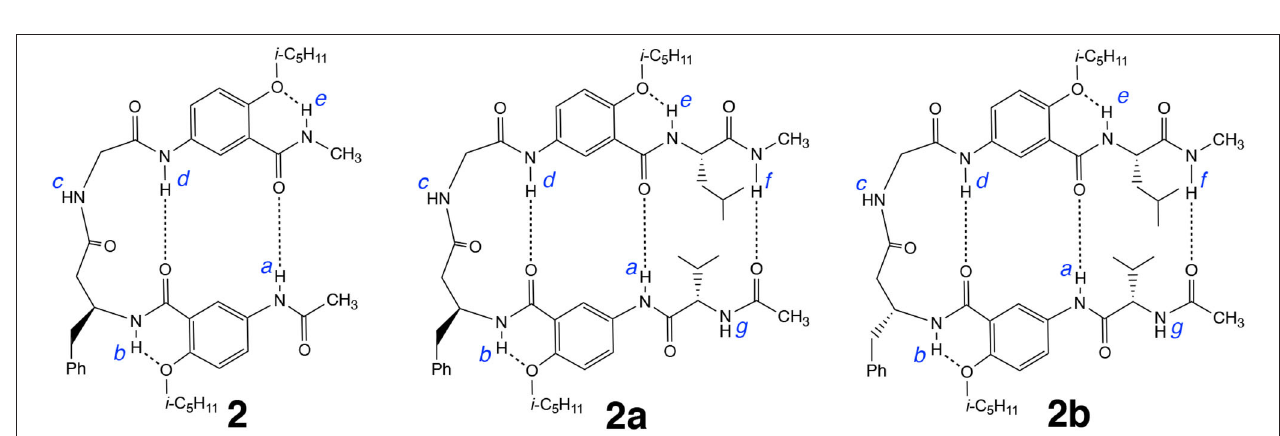
FIGURE 5 | Partial NOESY spectra of hexapeptide 1a (5mM) in 1, 1, 2, 2-tetrachloroethane- d 2 containing 5% DMSO- d 6 (600 MHz, 298K, mixing time: 300ms). Major NOEs are indicated by double-headed arrows in the structure. Partial NOESY spectra showing NOEs between protons a and h , c and d , and d and l are included in the Supplementary Materials .